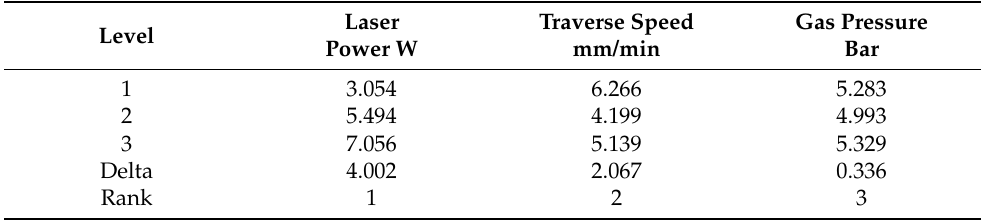
Figure 5. S/N ratio better average value of input cutting parameters of the 6 mm thickness of sugar palm fiber reinforced unsaturated polyester (SPF-UPE) composite cut by laser beam cutting process. Table 14. S/N ratio response table of input cutting parameters of the 6 mm thickness off SPF-UPE composite cut by the laser beam cutting process.